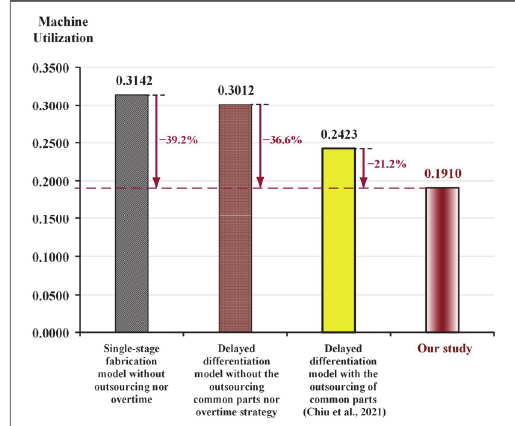
Fig. 19. The comparison of our machine utilization with that in other similar